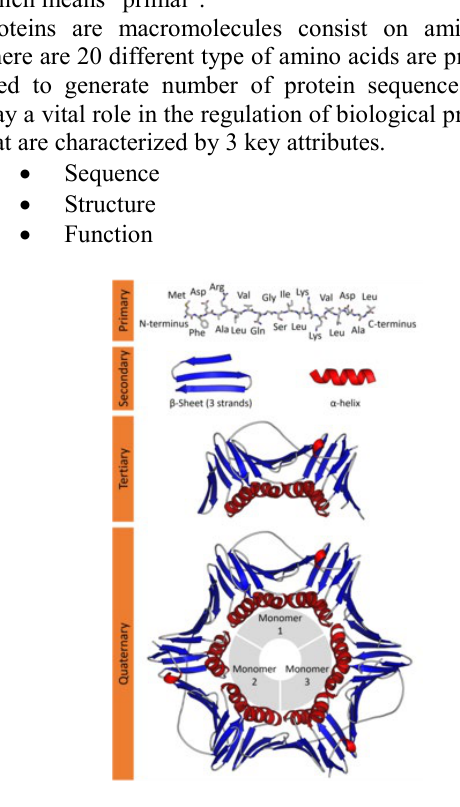
Figure 1. Structure of a Protein Molecule